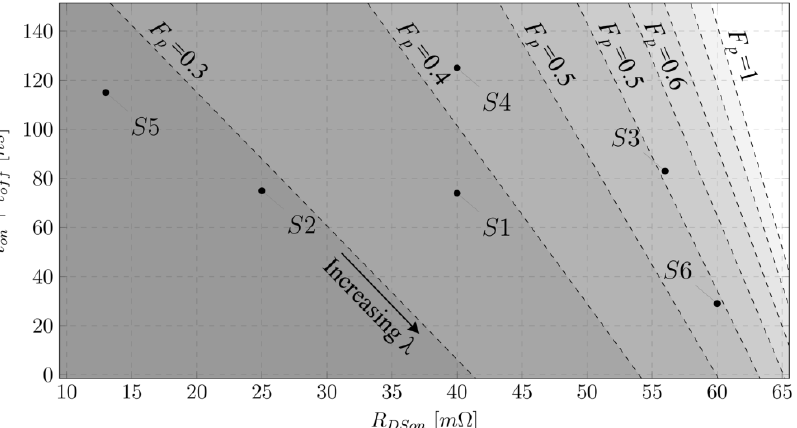
Figure 6. Relation between the SiC MOSFET turn-ON plus turn-OFF times with the channel ON-state resistance for a minimum efficiency of 99.3% at diffent values of the load power factor with a constant output load resistance and modulation index.